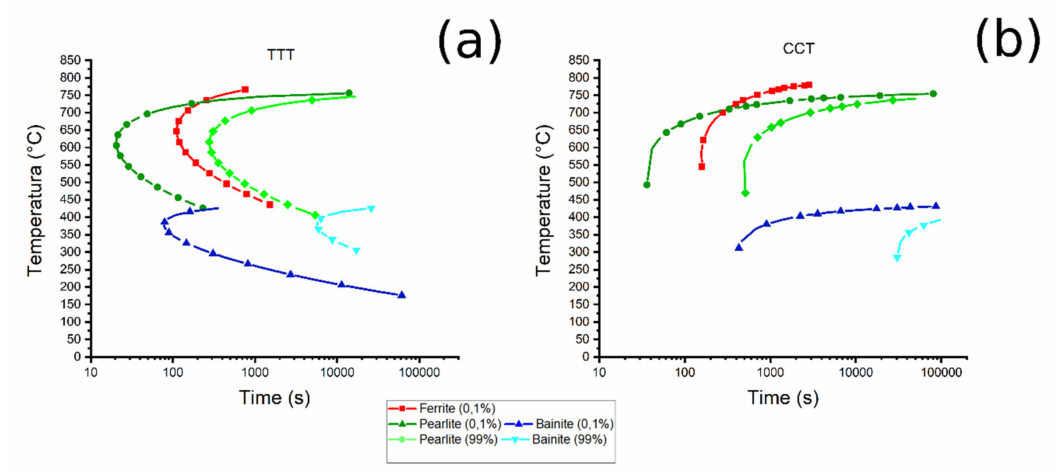
Figure 2. ( a ) TTT, ( b ) CCT curves calculated with JMat Pro software for heat treatment design.